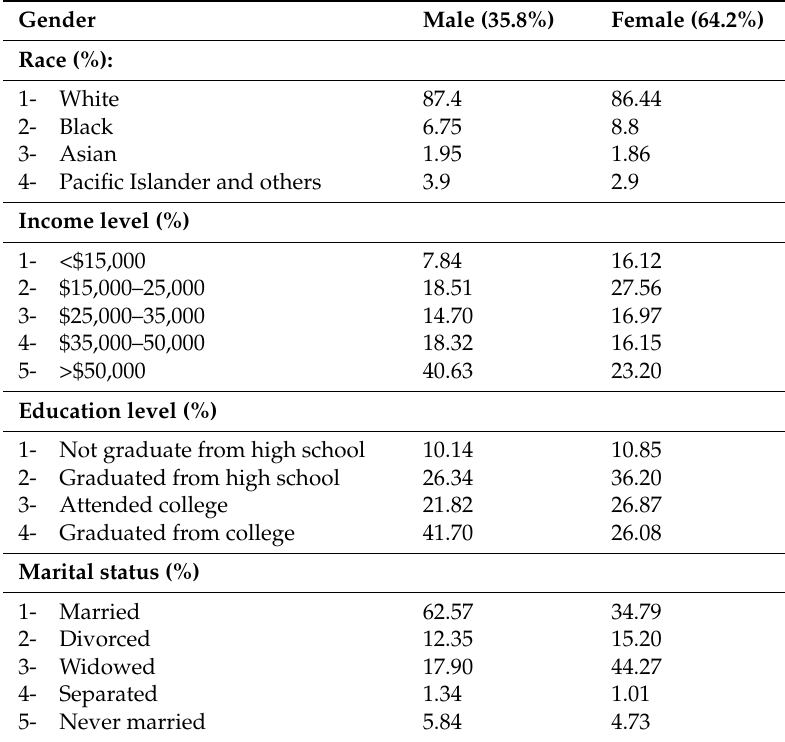
Table 3. Descriptive statistics of respondents aged 65 years and